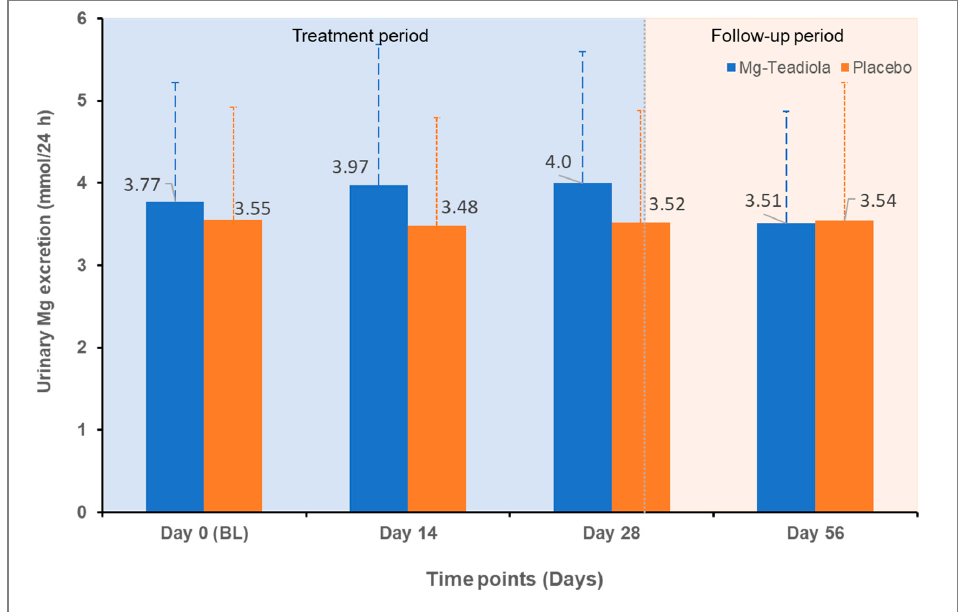
Figure 5. Excretion of magnesium in urine over time with Mg-Teadiola versus placebo. Values are presented as Mean (SD). Error bars represent SD. BL, baseline; Mg, magnesium; Mg-Teadiola, combination of 150 mg magnesium, 0.7 mg vitamin B6, 0.1 mg vitamin B9, and 1.25 µg vitamin B12, +222 mg of rhodiola extract and 125 mg of green tea extract including 50 mg of L-theanine; SD, standard